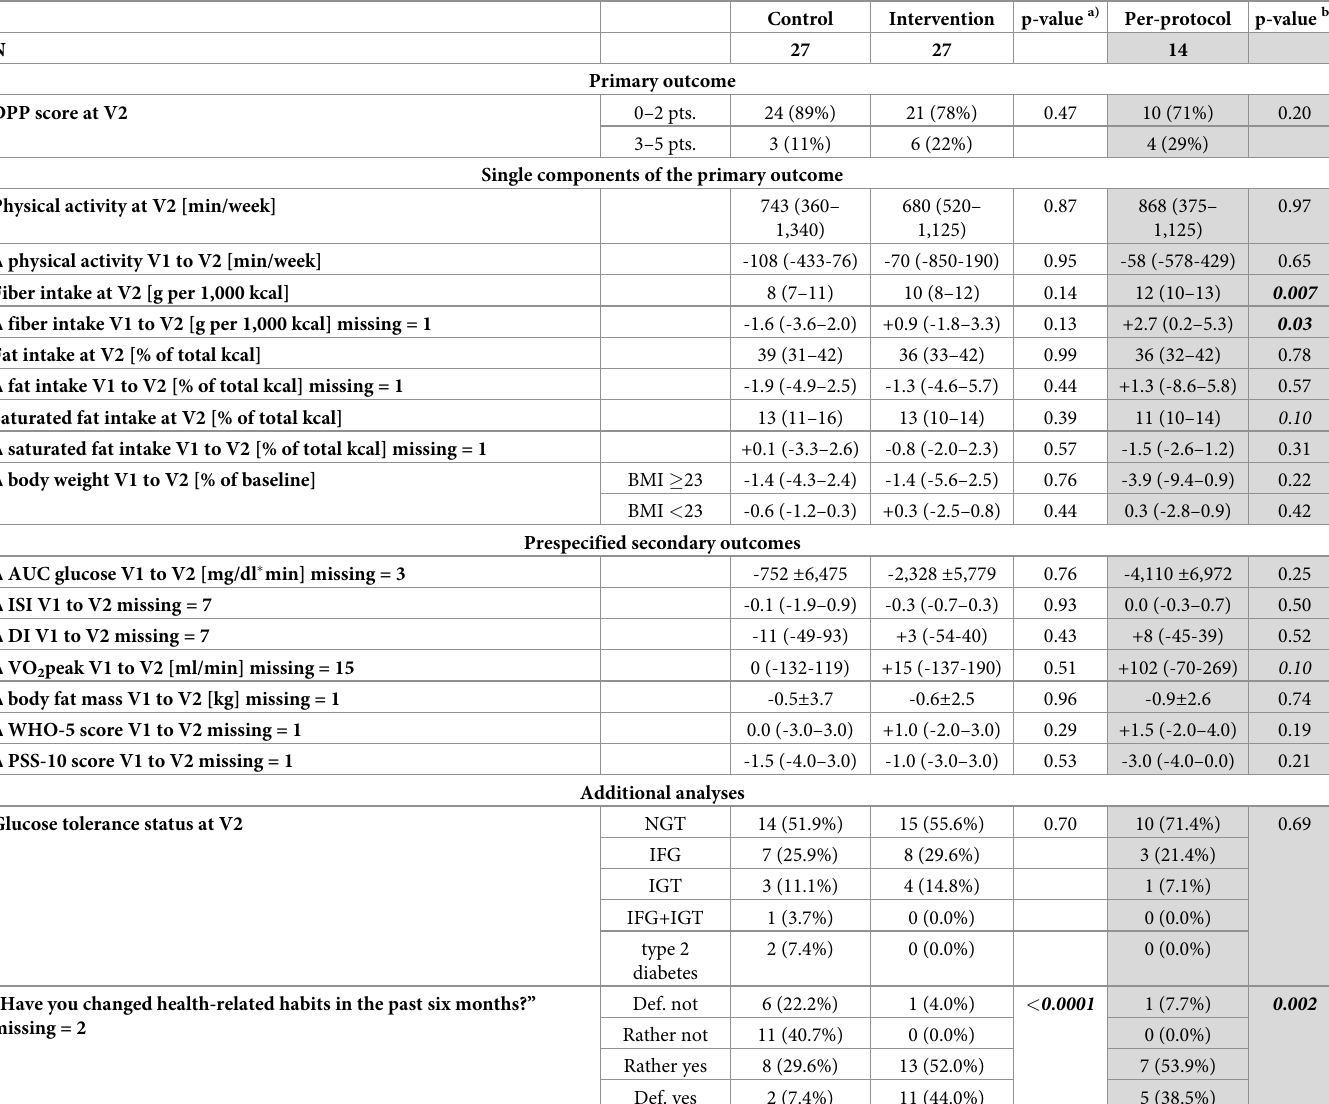
Table 2. Group comparisons in the primary and secondary outcomes between the control, intervention, and per-protocol group in the Test TRIANGLE